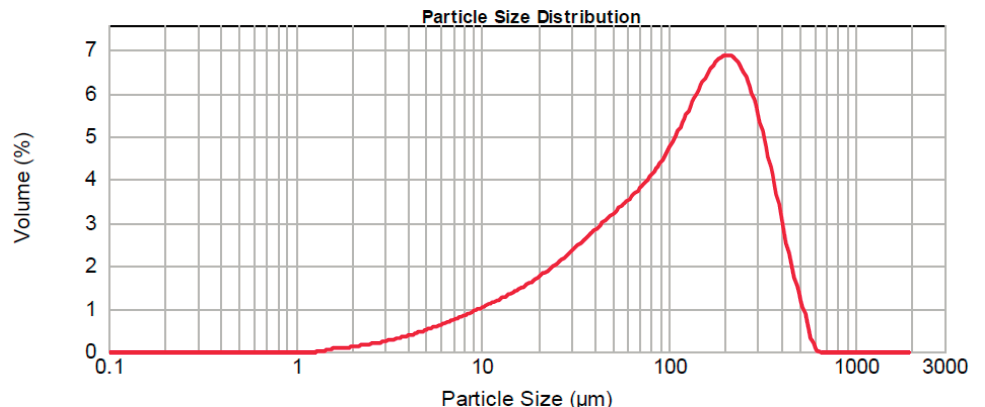
Figure 10. Graph of particle size distribution of LUSI mud.